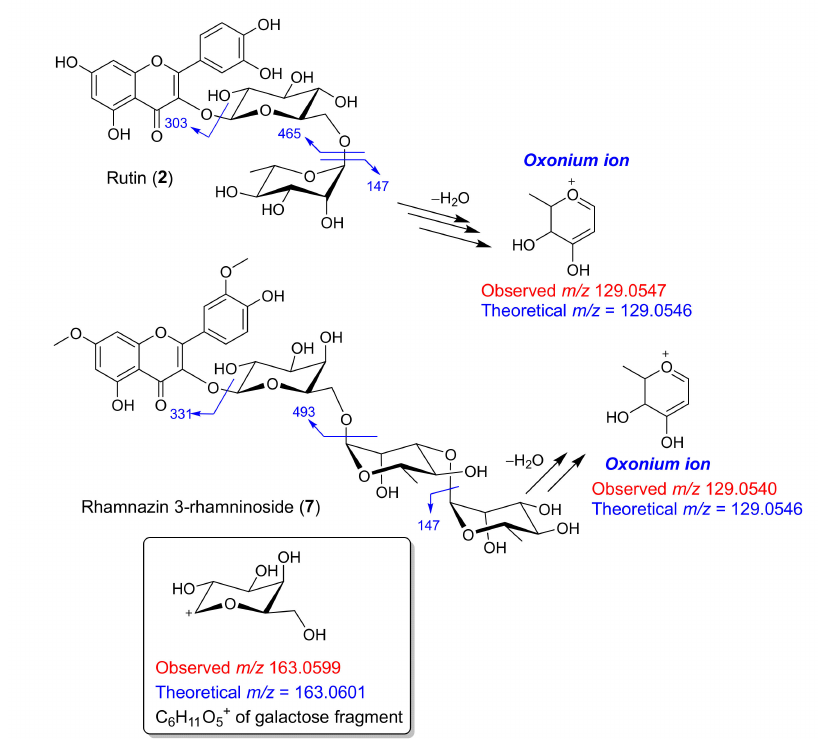
Figure 4. Typical MS fragmentation a standard compound, rutin ( 2 ), MS fragmentation of rhamnazin 3-rhamninoside ( 7 ) and an oxonium ion of rhamnose at m / z 129.0 and a galactose fragment ion at m / z